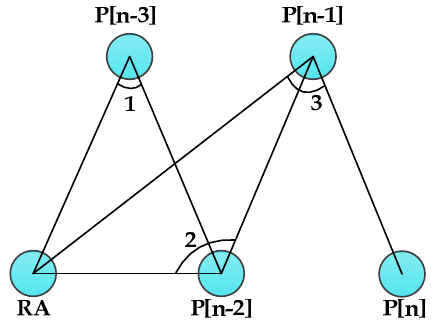
Figure 4. An example of single DAMST angle analysis.